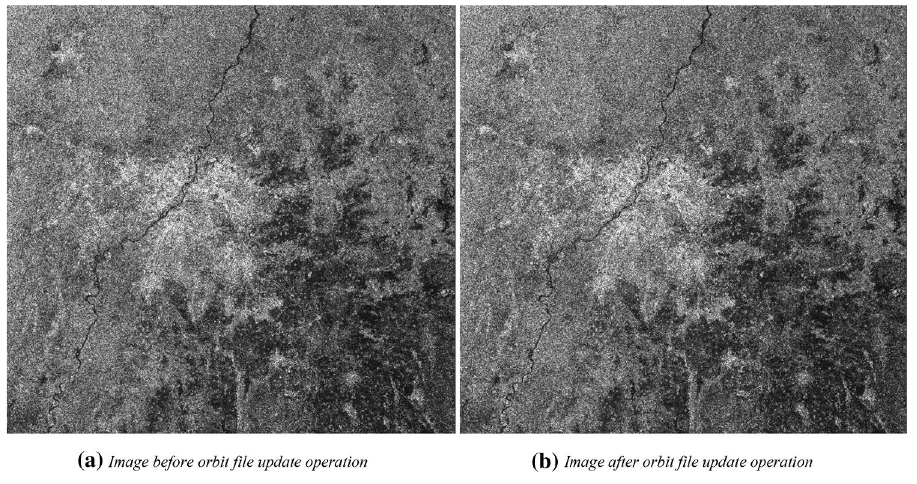
Figure 4. Effect of orbit file update operation in VH